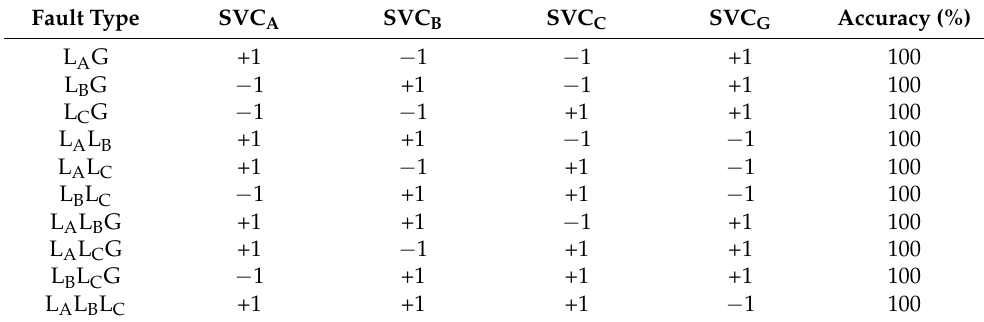
Table 1. SVC training matrix accuracy.